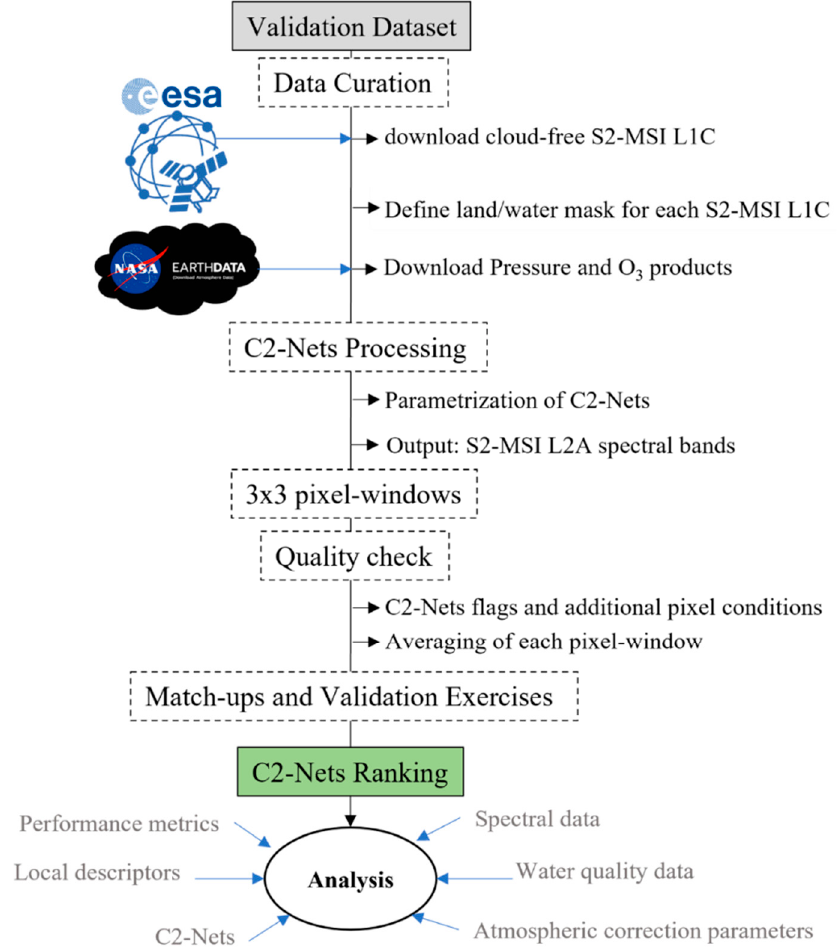
Figure 3. Figure 3. Workflow.